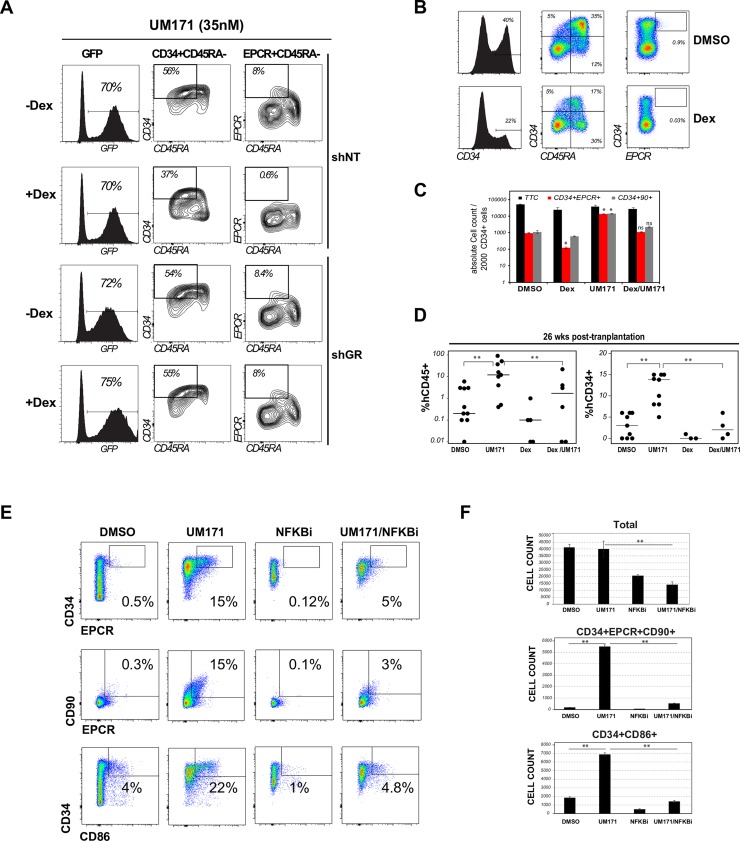
Immunosuppressors abolish UM171 activity in HSPC.A: CD34+ cord blood cells engineered to express shNT (GFP) or shNR3C1 (shGR) were cultured for 7 days with UM171 (35nM) in presence or absence of Dex (100nM). UM171-mediated expansion of HSC (CD34+CD45RA-EPCR+) subset from transduced (GFP+) cells were evaluated by flow cytometry. B: CD34+ cord blood cells were cultured for 7 days in presence of vehicle or Dex only (100nM). Representative FACS profiles show a reduction of HSCs (CD34+EPCR+) and progenitors (CD34+ and CD34+CD45RA+) in presence of Dex. C: CD34+ cord blood cells were exposed to DMSO, UM171 (35nM), Dex (100nM) or UM171 and Dex for 7 days and co-stained with CD34, EPCR and CD90 antibodies. Total cell counts and counts of HSC enriched subsets are presented. Data show mean ±SEM of 2 independent experiments performed in triplicate. D: Day 7 cultures were transplanted in immunocompromised NSG mice (outcome of 2000 day 0 cells). Human CD45 and CD34 engraftment were assessed at 26 weeks post-transplantation. E: CD34+ cord blood cells were cultures for 5 days in presence of DMSO, UM171 (35nM), NFKB inhibitor (EVP4593, 100nM) and UM171 + EVP4593. FACS profile (left panel) and absolute counts (right panel) of CD34+EPCR+, CD34+EPCR+CD90+ and CD34+CD86+ cells are shown. Data show mean ±SEM of 2 independent experiments performed in triplicate.